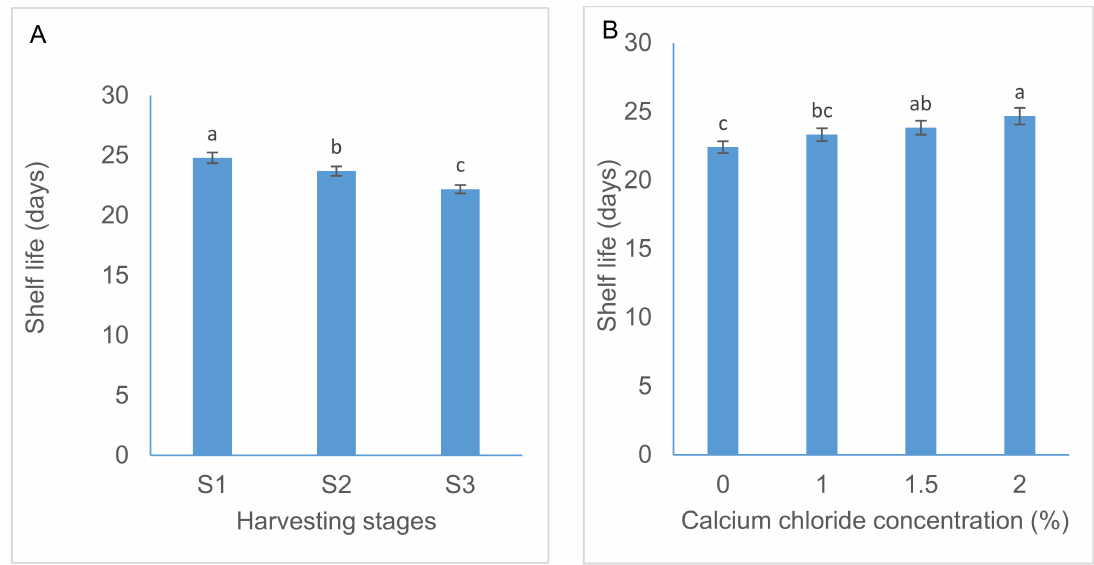
Figure 12. Effects of harvesting stages ( A ) and percent CaCl 2 ( B ) on shelf life (days) of tomato fruit stored at ambient temperature (28 ± 2 ◦ C and 75 ± 5% RH). Means followed the same letters are not significant at LSD at p = 0.05, where the vertical bars indicate the standard error of means for four